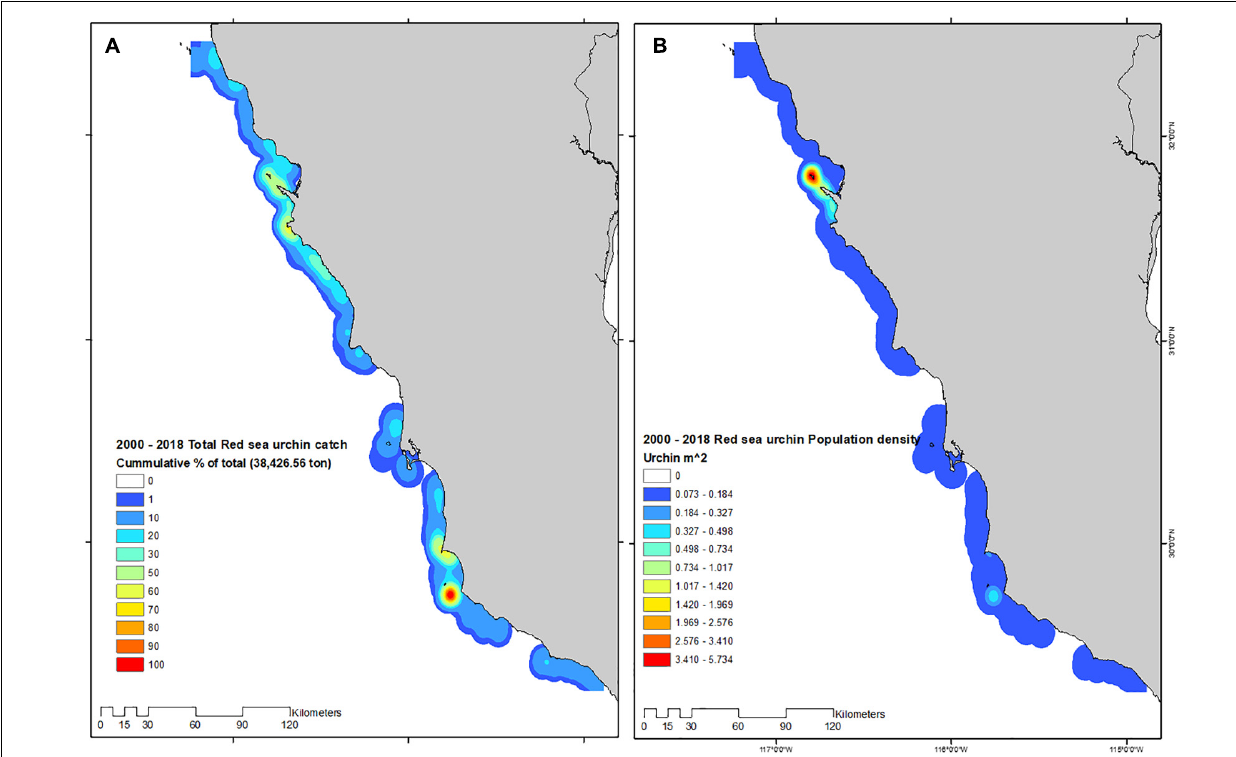
FIGURE 7 | Total catch (A) , and population density (B) estimated for the 2000–2018 red sea urchin fishing seasons.